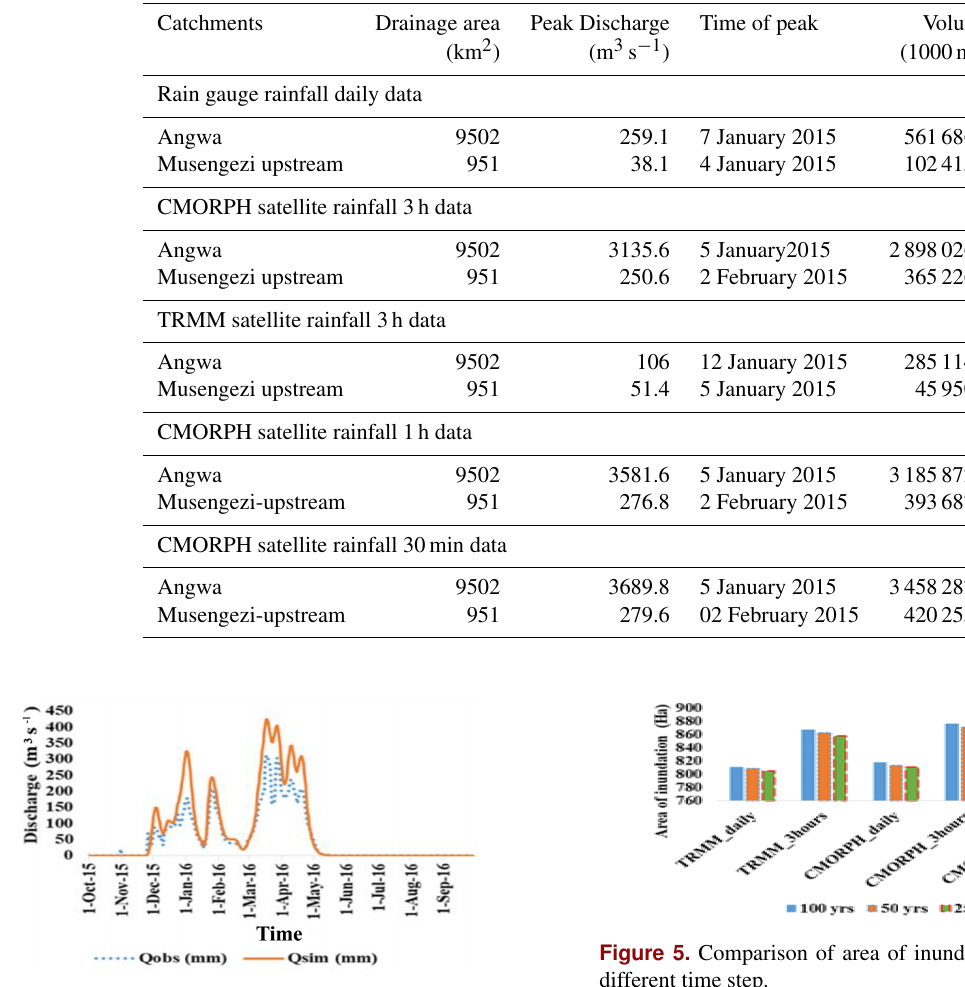
Figure 4. Validation hydrograph for Angwa.